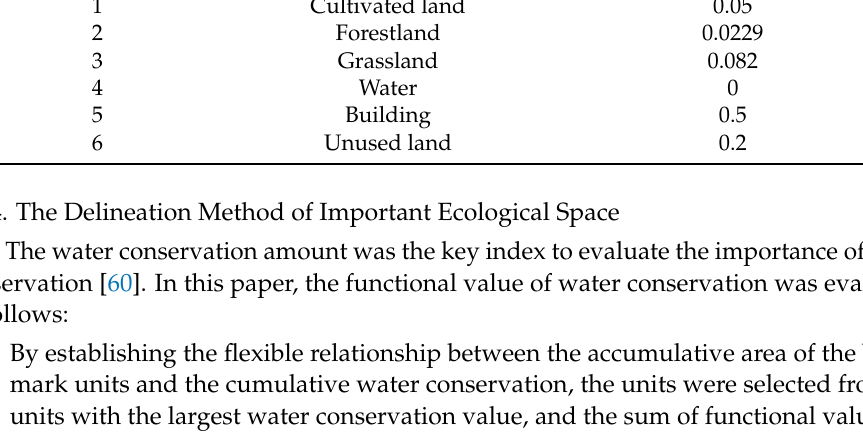
Table 2. The surface runoff coefficient’s value of different land types. Land Number Land Use